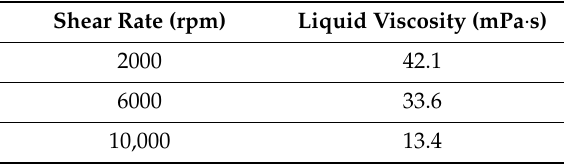
Figure 8. Effect of shear rate on the wastewater treatment on the ( a ) oil removal efficiency and ( b ) Figure 8. E ff ect of shear rate on the wastewater treatment on the ( a ) oil removal e ffi ciency and ( b ) filtration rate, operating condition: O/W = 20/80, HPAM = 50 ppm. Table 2. E ff ect of shear rate on the liquid